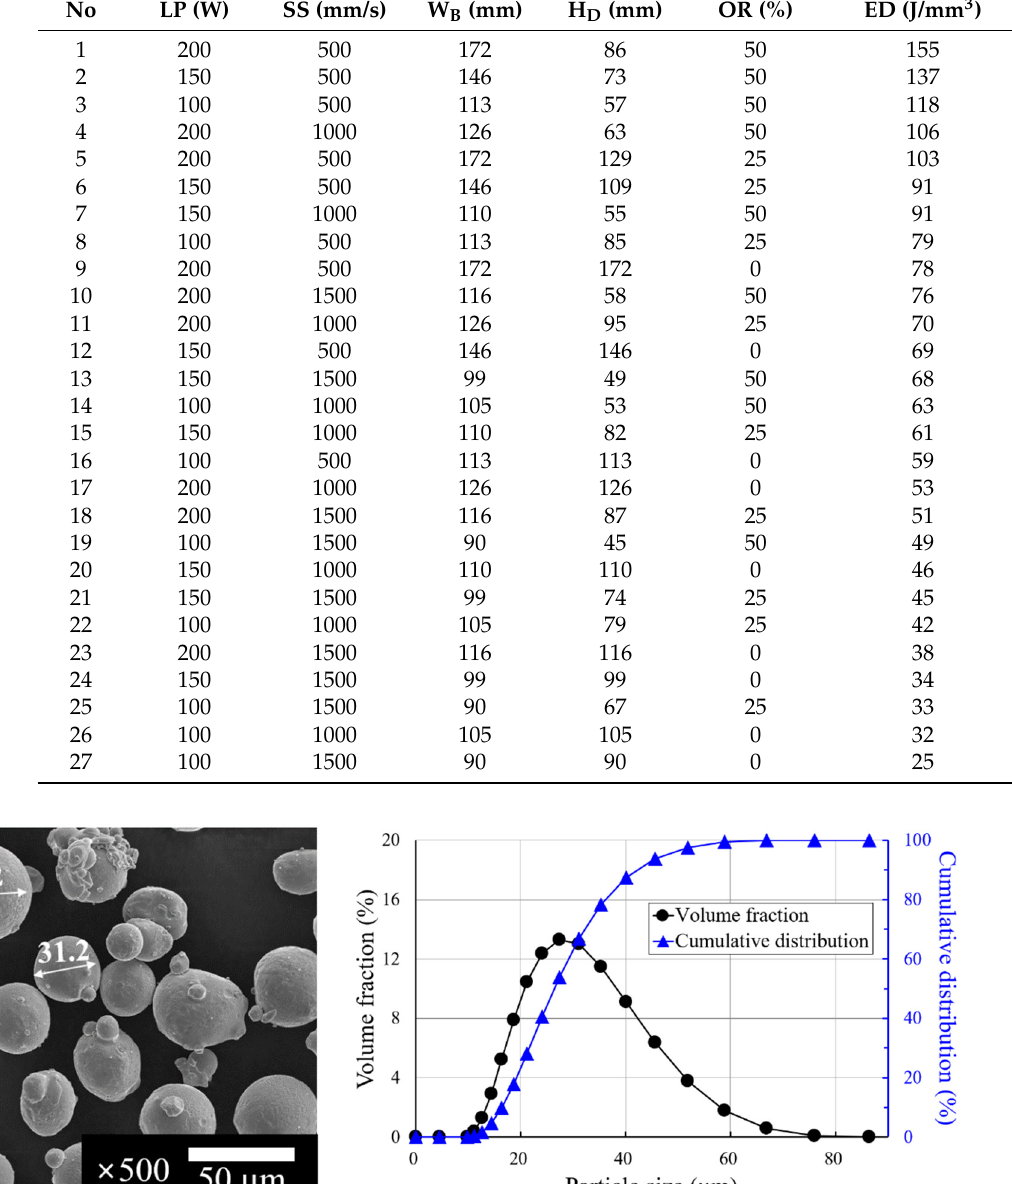
Table 1. Parameters and conditions for cuboid deposition experiments.